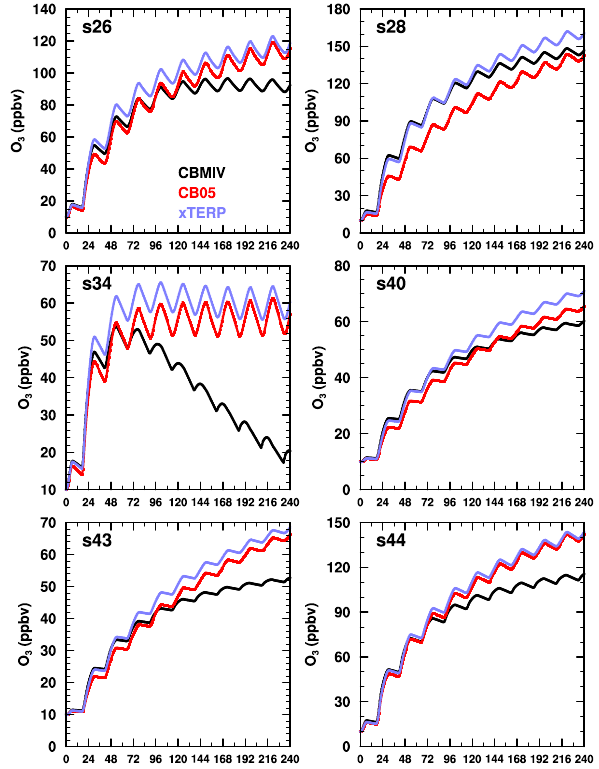
Fig. 5. Example scenario results for sensitivity test xIOLE. Ozone Figure 5 . Example scenario results for sensitivity test xIOLE . Ozone mixing ratios (ppbv) 3 mixing ratios (ppbv) for the base CB05 (red), base CBMIV (black) for the base CB05 (red), base CBMIV (black) and sensitivity test xIOLE (violet) over the 240 4 hr simulation period. 5 and sensitivity test xIOLE (violet) over the 240h simulation period. 6